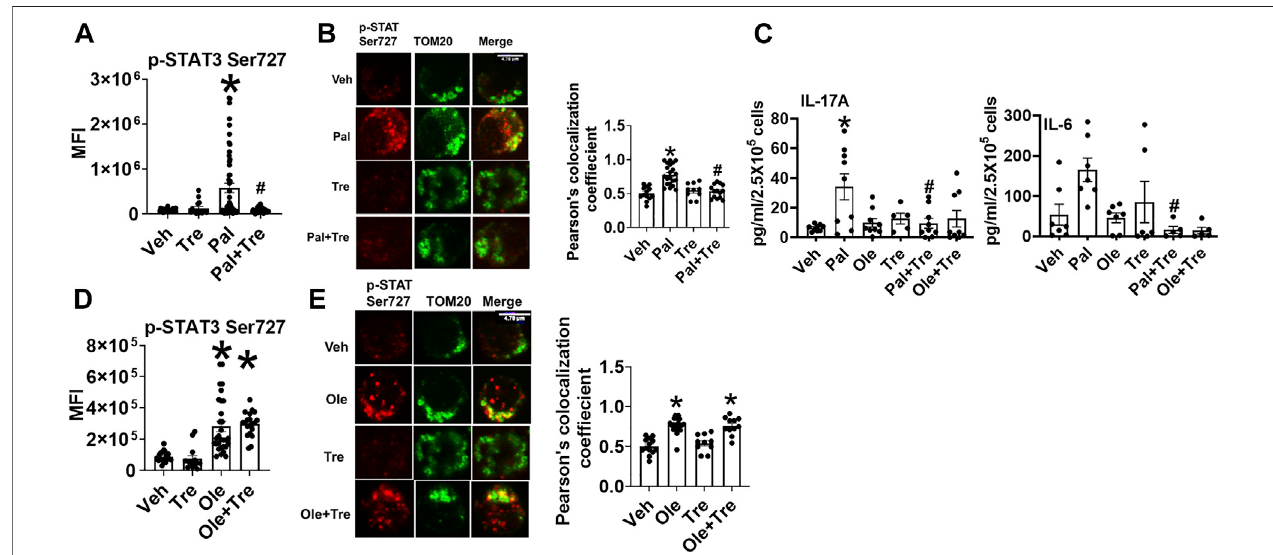
FIGURE 4 | Nutraceutical trehalose blocks p-Ser 727- STAT3 mitochondrial translocation and lowers in fl ammation in palmitate but not oleate-treated cells. (A) p-Ser-727 STAT3 expression; (B) mitochondrial localization (left panel representative images and right panel quanti fi cation); and (C) cytokine production in cells after palmitate and trehalose treatment. (D) p-Ser727STAT3 expression and (E) mitochondrial localization (left panel, representative images, and right panel quanti fi cation) afteroleateandtrehalosetreatment.N=5 – 8forpanels (A,B,D,E) and N =7 – 9forpanel (C) .EachNrepresentscellsobtainedfromonesubject.Atleast7 – 10 fi elds per slide were imaged at 63× magni fi cation with oil immersion, on a Zeiss LSM 800 confocal microscope. In fi elds where numerous cells/ fi elds were observed, the averages are plotted. The brightness of the images was enhanced to improve clarity. * p < 0.05 vs. lean or NGT, # p < 0.05 vs. NGT.